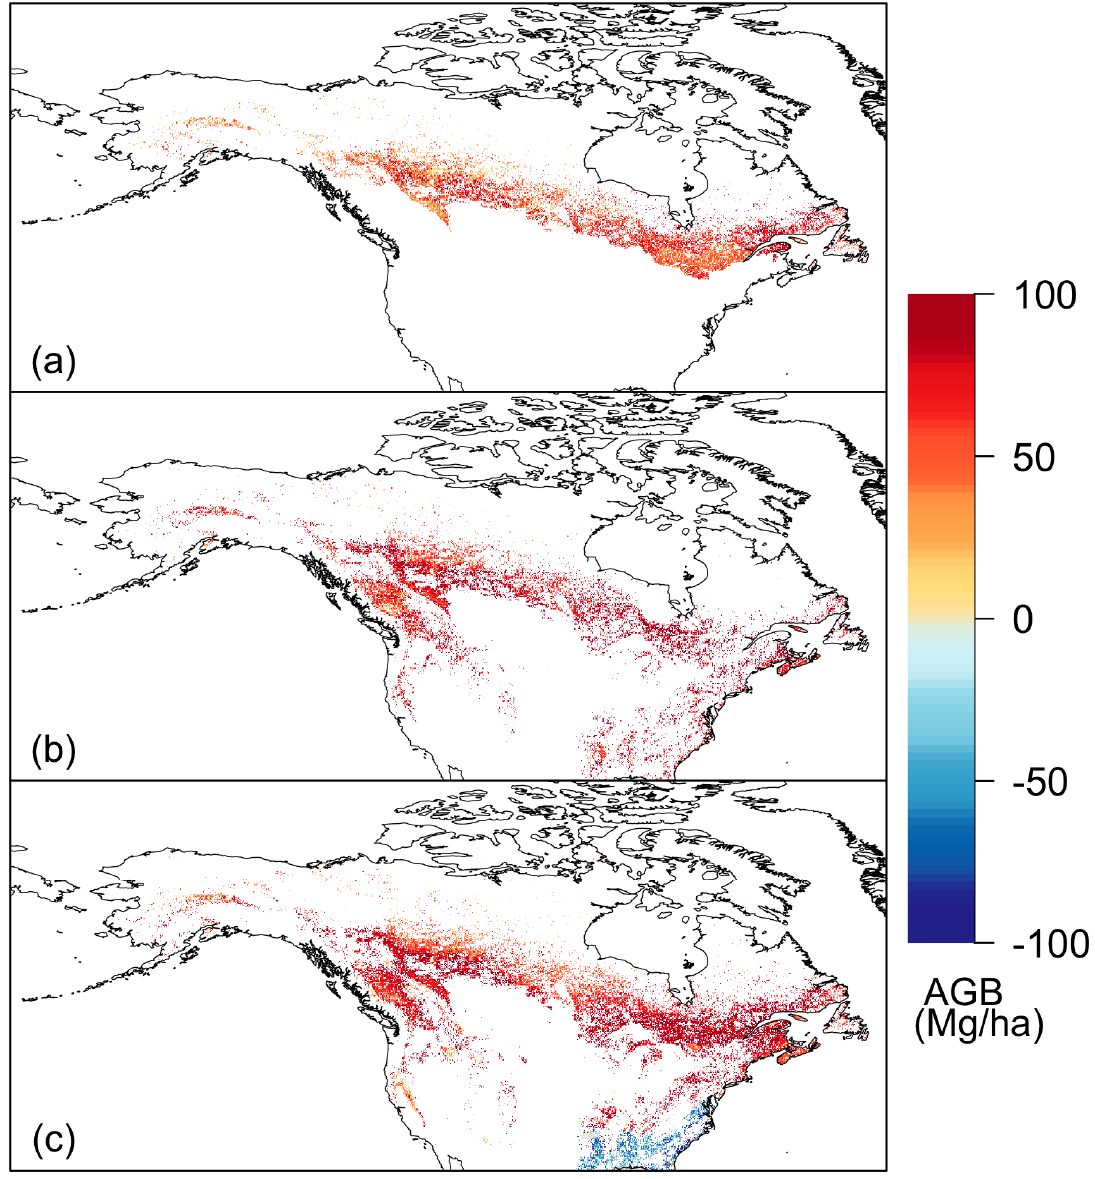
Figure 9. The difference map between our global wall-to-wall forest AGB product and the products from ( a ) Margolis et al. (2015) [74]; ( b ) Thurner et al. (2014) [54]; and ( c ) Reusch & Gibbs (2008) [73] in the North America forest area.